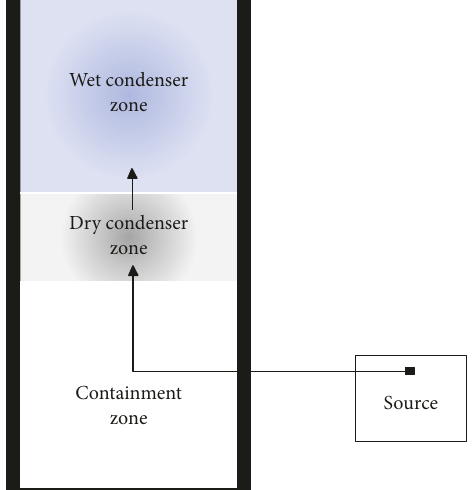
Figure 8: Nodalization of containment vessel of Ph´ebus FPT3 experiment in RELAP5 Mod